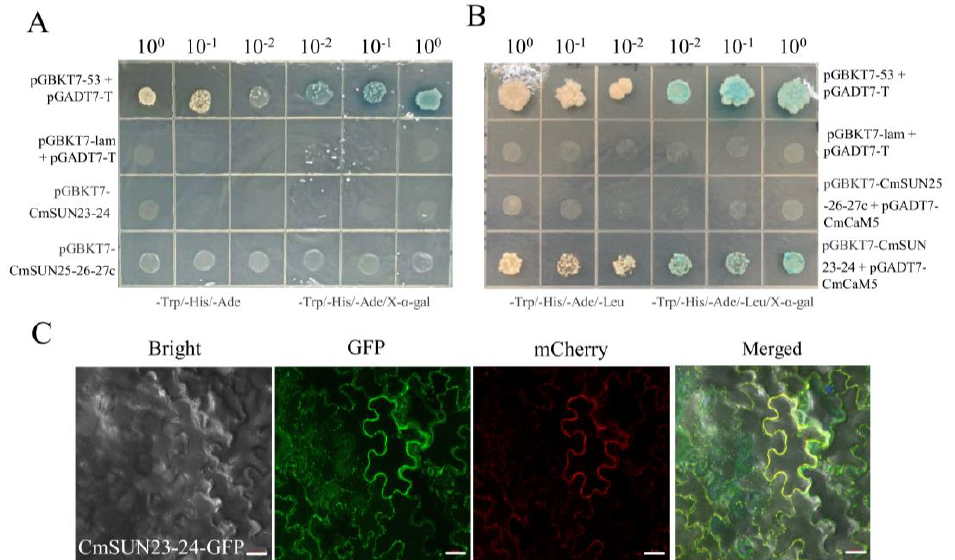
Figure 10. CmSUN23-24 has a protein interaction with CmCaM5. ( A ) Transcriptional activation of CmSUN23-24 and CmSUN25-26-27c protein. pGBKT7-53 + pGADT7-T and pGBKT7-lam + pGADT7-T were served as positive and negative control, respectively. The values 10 0 , 10 1 and 10 2 indicate different concentration solutions; -Trp/-His/-Ade indicates DO supplement; X-α-gal was a chromogenic substrate of yeast galactosidase. ( B ) Yeast-two hybrid assays were performed between CmSUN23-24, CmSUN25-26-27c, and CmCaM5. ( C ) Subcellular localization of CmSUN23-24 in tobacco leaves. Bright indicates light field; GFP indicates green fluorescence excitation field; mCherry indicates fluorescence excitation field; Merged indicates the overlapping of the three fields. Scale bar = 20 μm.